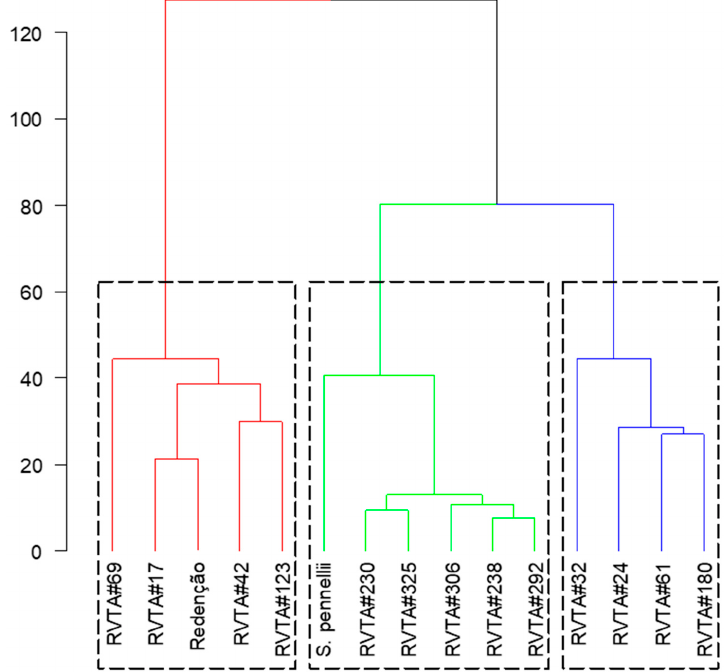
Figure 5. Hierarchical clustering of tomato genotypes, considering acylsugar content and mites and whiteflies behavior in choice and no ‐ choice bioassays.